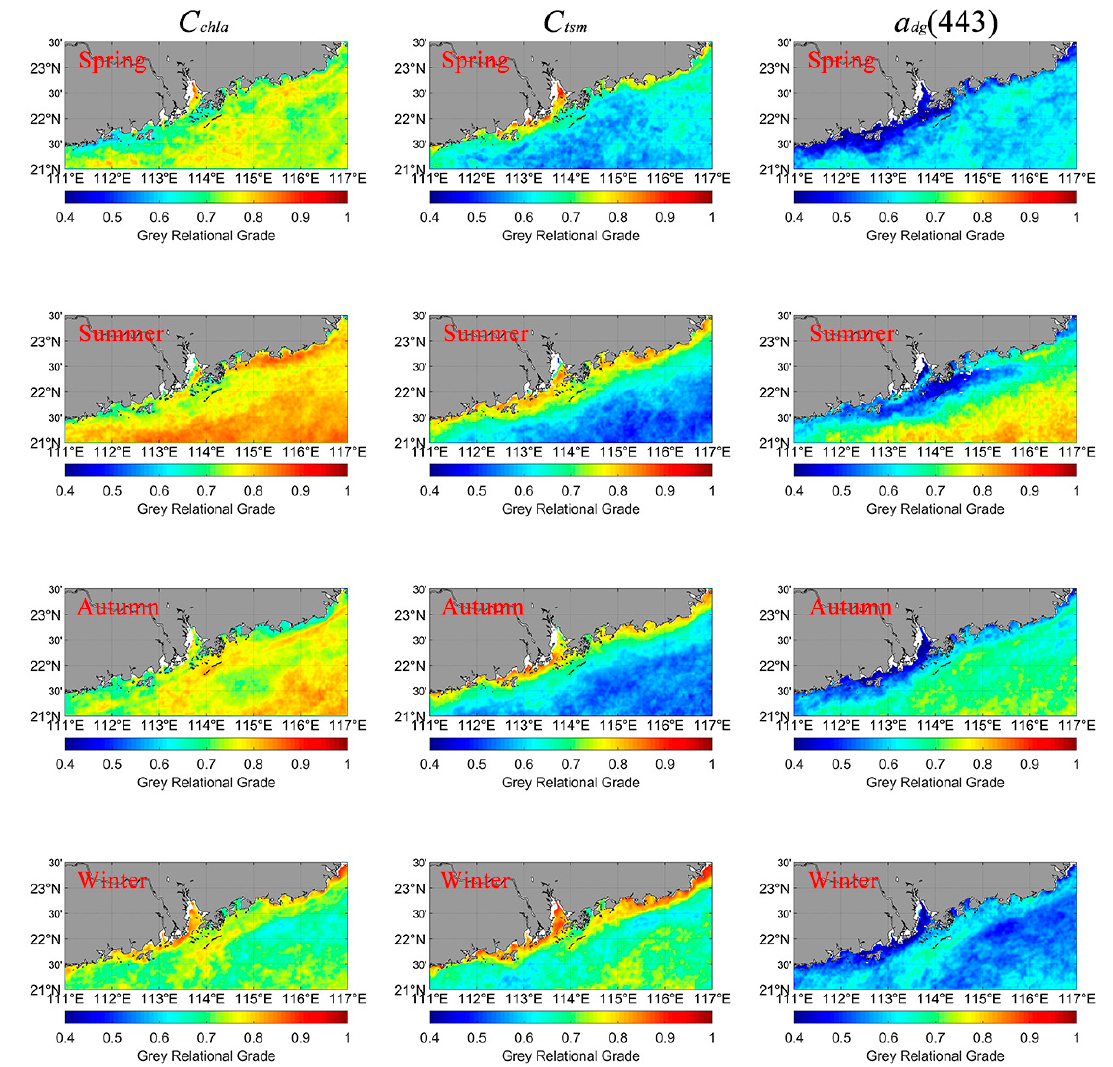
Figure 5. Grey relational grades (GRGs) between K d (490) and water constituents in four seasons. Spatially, GRGs between K d (490) and C chla or a dg (443) were higher in the clear open ocean region than in the coastal region, but the values contrasted between K d (490) and C tsm . The GRGs gradually decreased from nearshore to offshore, similar to the distribution of C tsm . Seasonally, the GRG was higher in summer and autumn than in spring and winter between K d (490) and C chla , with most of the pixels’ values being above 0.8. Similar phenomena were observed in the GRGs between K d (490) and a dg (443), although the average value was lower than between K d (490) and C chla .